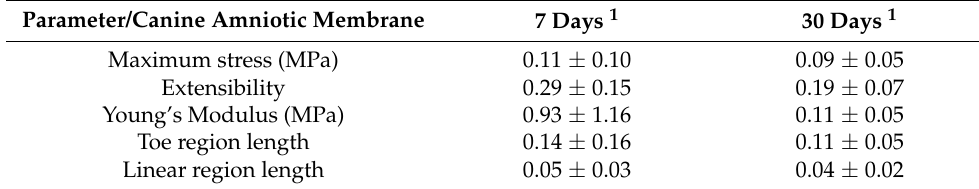
Figure 1. Representative stress–strain curves (MPa) of canine amniotic membranes after: ( a ) 7 days; ( b ) 30 days of cryopreservation. Table 1. Median ± interquartile range of tensile strength parameters of canine amniotic membranes that were cryopreserved for 7 days and 30